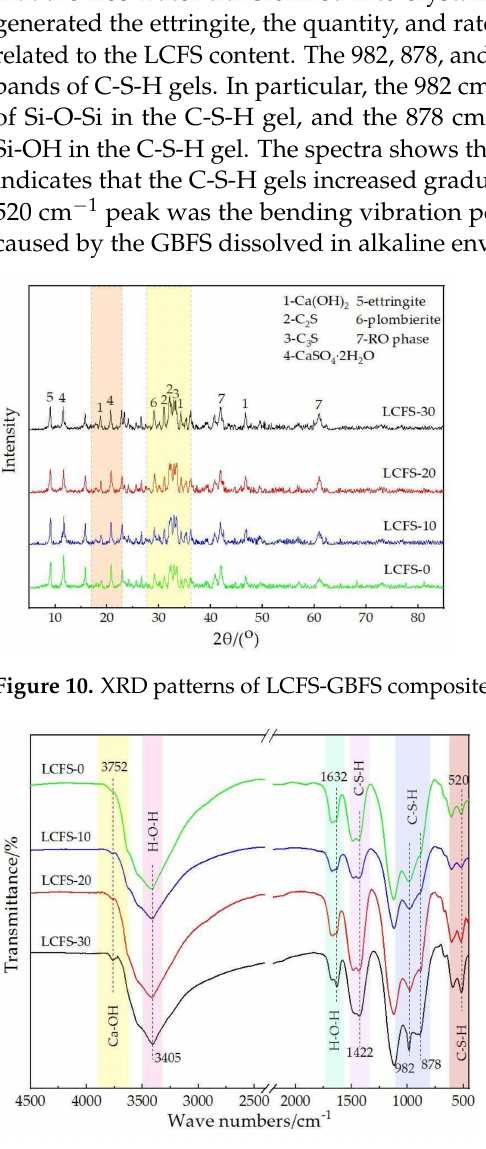
Figure 11. FTIR analysis of the samples with different LCFS content at 28